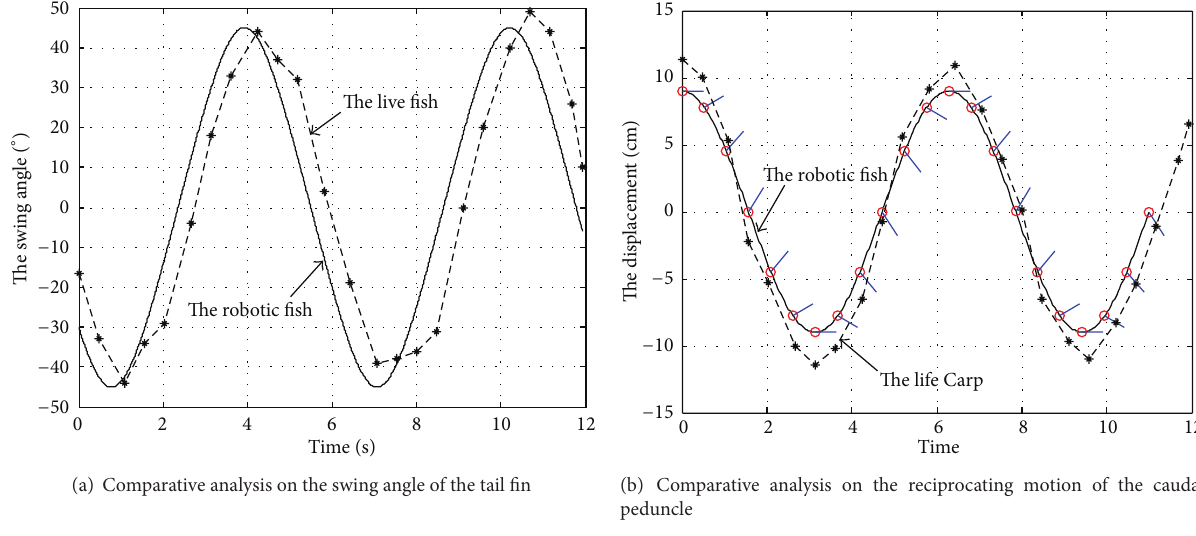
(b) Comparative analysis on the reciprocating motion of the caudal peduncle Figure 10: Comparative analysis of the driving system and a live